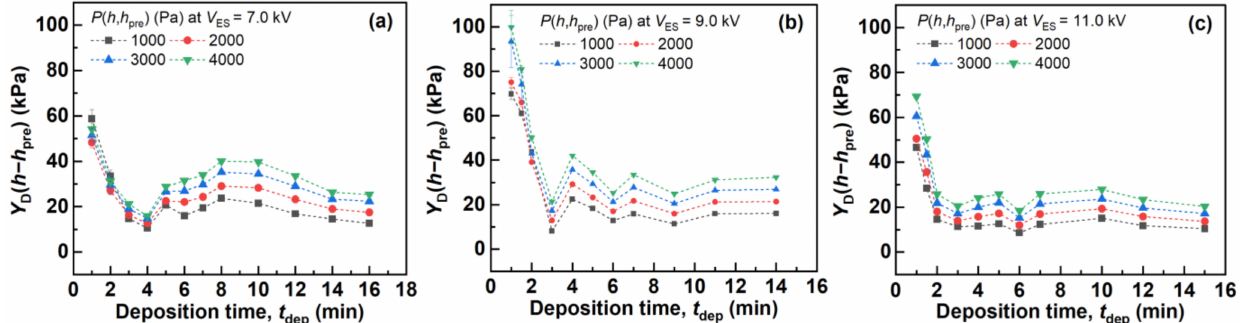
Figure 6. Y D ( h - h pre ) of the fiber mats produced with different t dep and V ES . ( a ) 7.0, ( b ) 9.0, and ( c ) 11.0 kV.